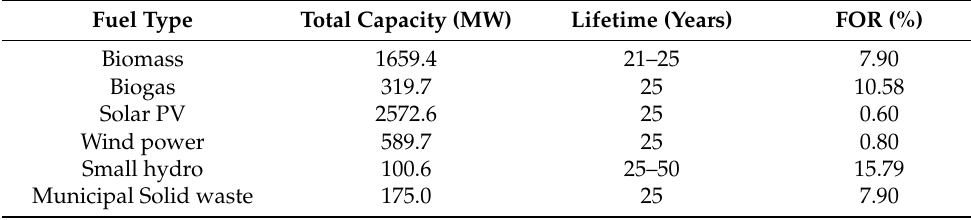
Table A2. Thailand’s renewable energy generation units as of December